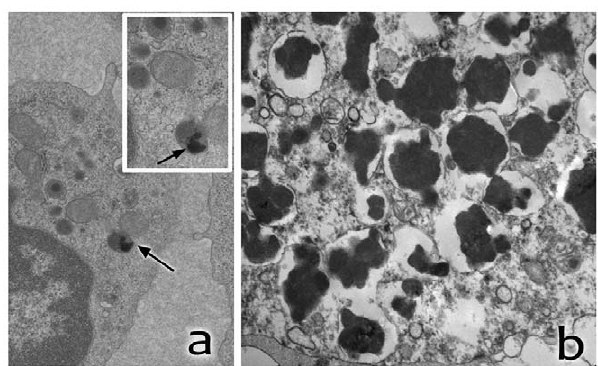
Figure 2. Laboratory studies of some of the individuals studied. a) EM study of peripheral lymphocytes of the proband of the Parry family showing storage inclusions with morphology of GROD (arrows). Higher magnification of the area is shown in the upper right corner. b) Neuropathology study of the father of individual KUF01CH showing neuronal accumulation, throughout the CNS, of PAS-positive material with strong, broad-range autofluorescence. and then calls consensus genotypes based on a statistical model, which maximizes the posterior probability and calculates a quality score at each position along the consensus (http://maq.